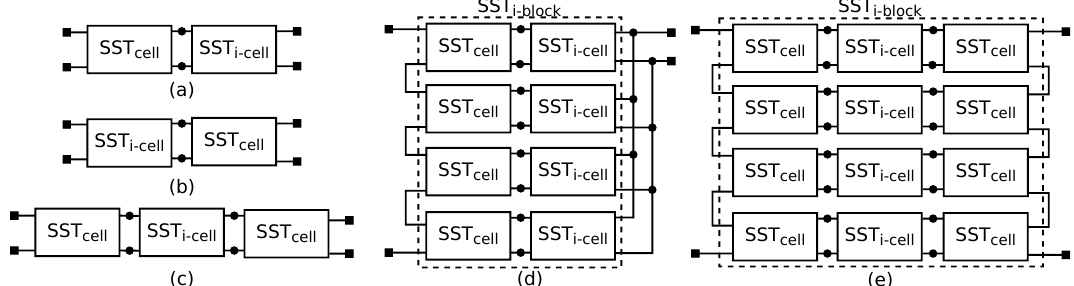
Figure 10. Stage extension at cell level and formation of SST i-block using multi-stage SST cell [54,58]: ( a ) two-stage SST cell , ( b ) two-stage SST cell , ( c ) three-stage SST cell , ( d ) two-stage SST cell in ISOP configuration, and ( e ) three-stage SST cell in ISOS configuration.